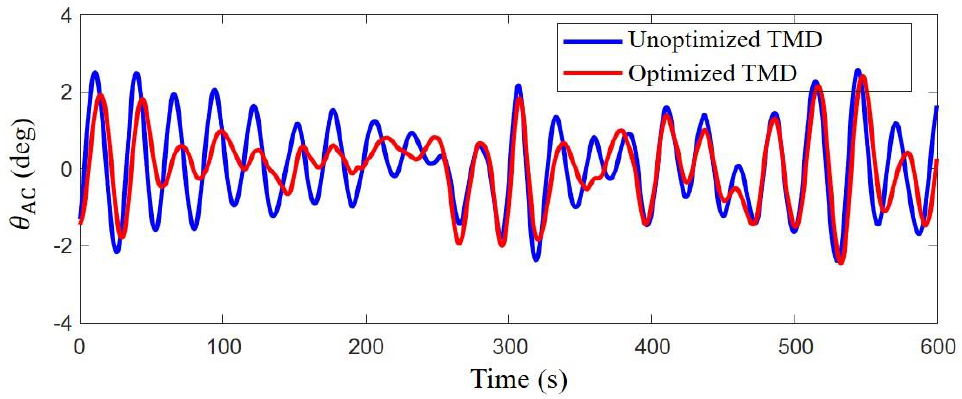
Figure 9. Motion fluctuation of the FOWT before and after optimization.